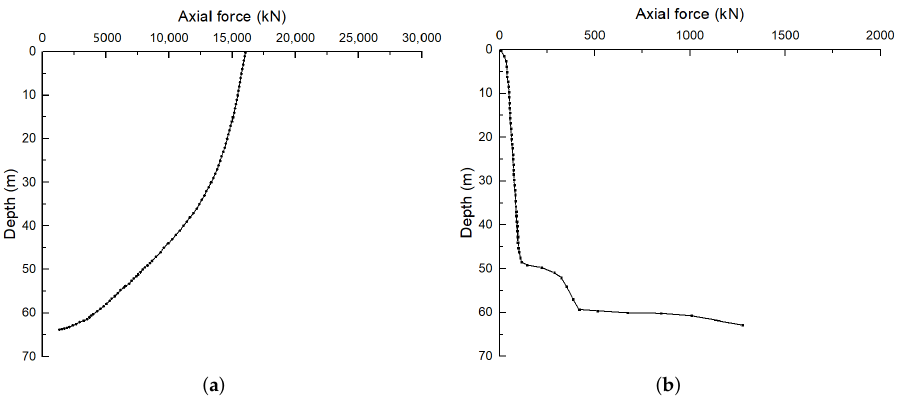
Figure 6. Axial force − Depth curves of ( a ) piles, and ( b ) cemented soil.